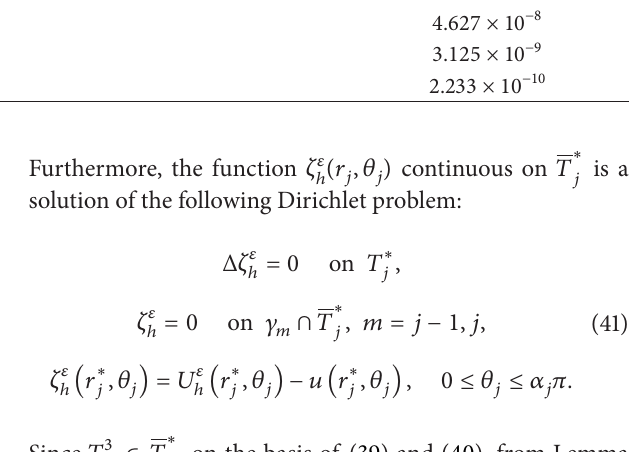
Table 4: In 𝐺 𝑆 ∩ 𝑟 ≥ 0.2 , the minimum errors of the derivatives over the pairs (ℎ −1 , 𝑛) in maximum norm when 𝜀 = 5 × 10 −13 . (ℎ −1 ,𝑛) Max